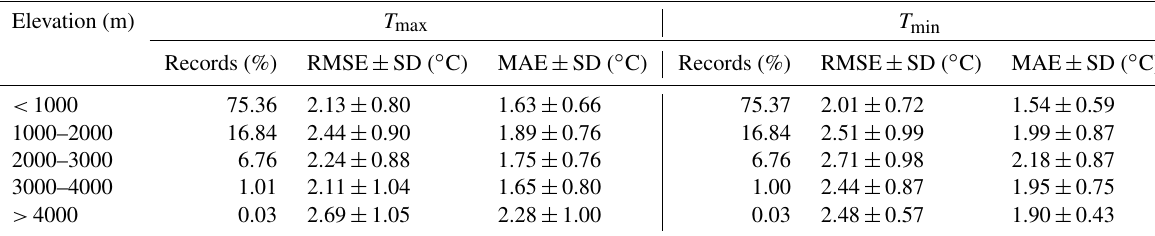
Snow/ice Note: SD represents the corresponding standard deviation. Table 3. Model performance for different elevation ranges in